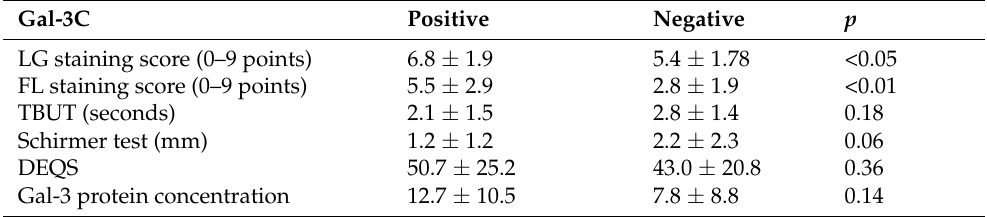
Table 3. The analysis of the ophthalmic evaluation factors in the Gal-3C positive or negative